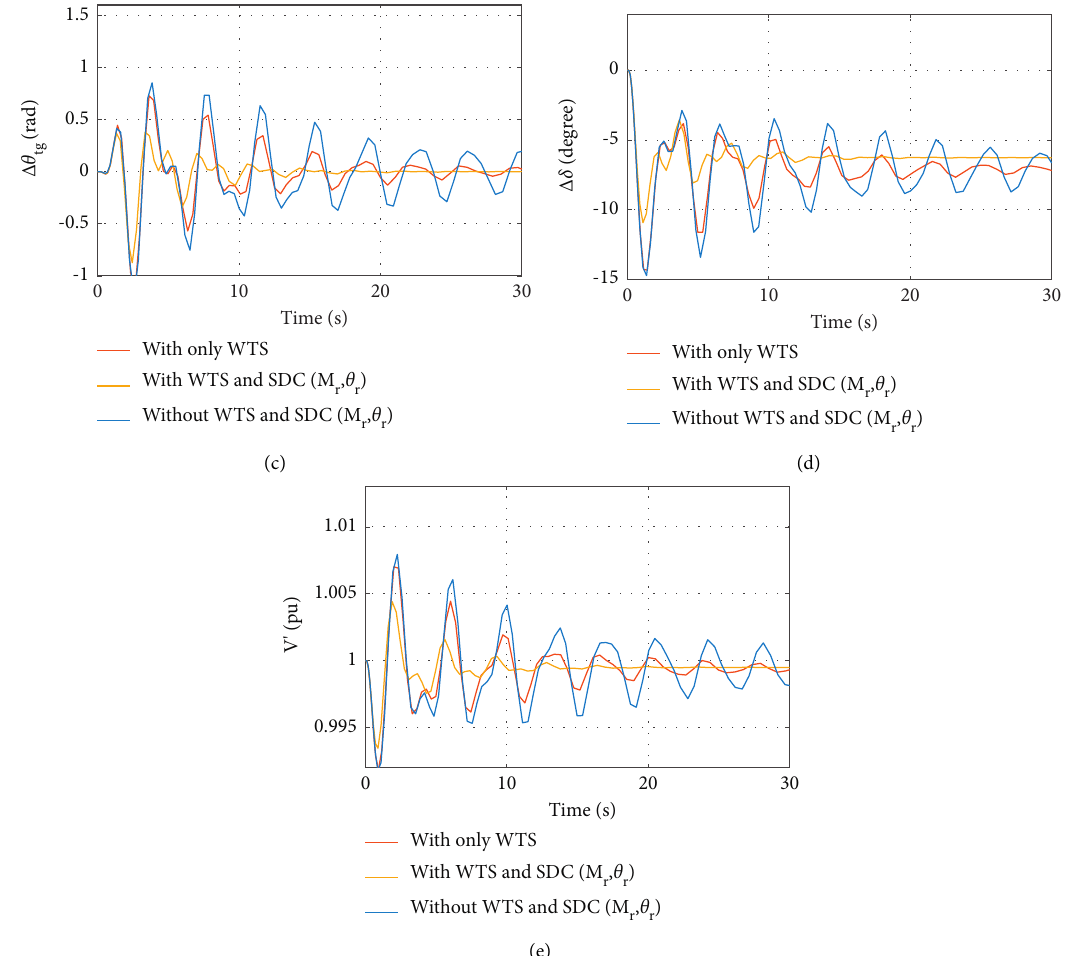
V w ≈ 12m/s). (c) The angular